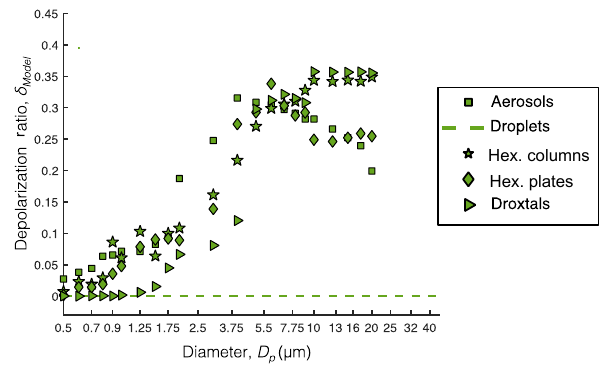
Figure 2. Depolarization ratio vs. diameter for modeled particles: droplets, aerosols, hexagonal column ice crystals, hexagonal plate ice crystals, and